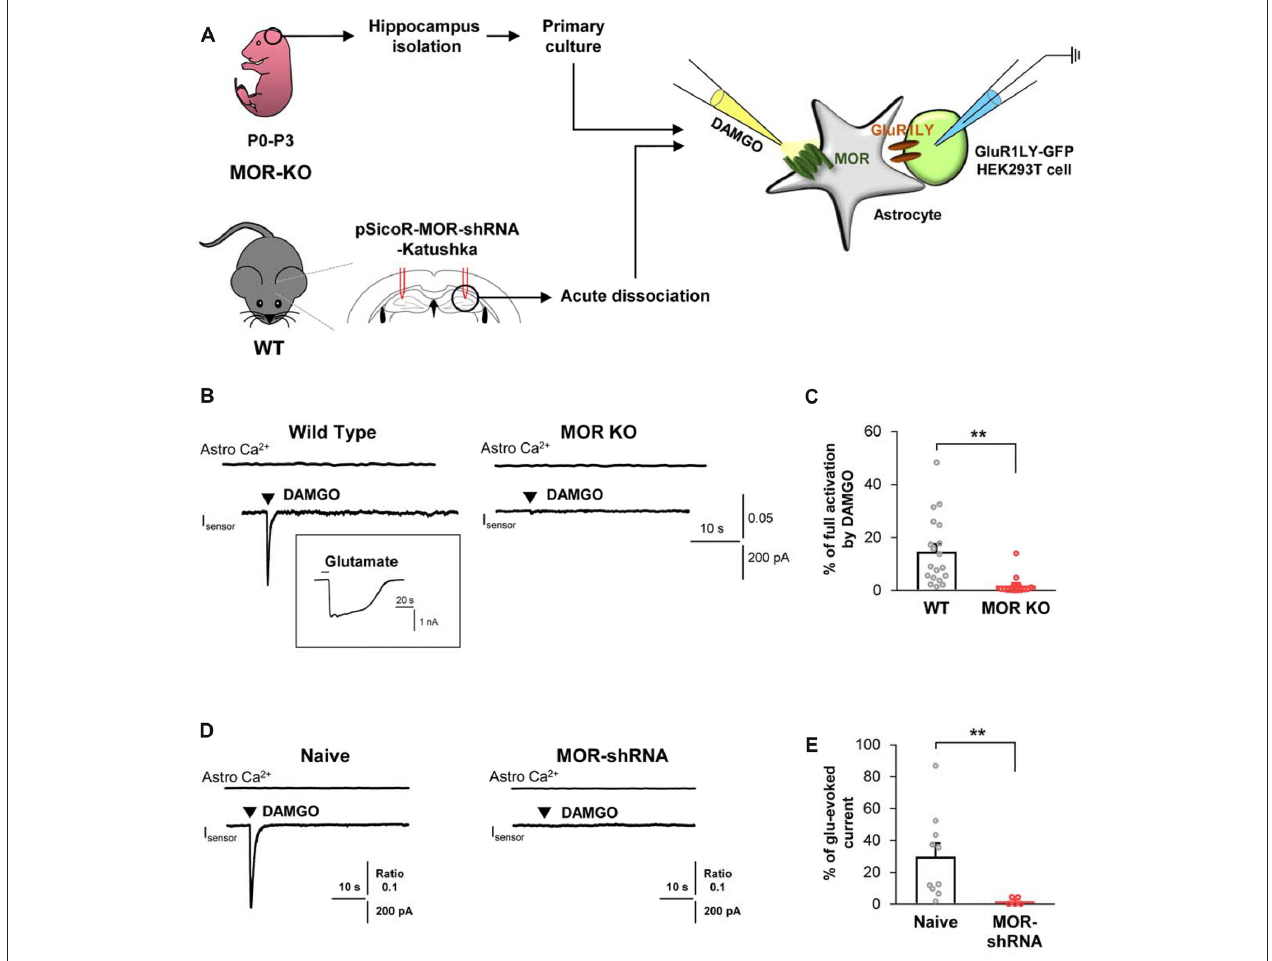
FIGURE 2 | DAMGO-induced astrocytic glutamate release is caused by MOR activation. (A) Schematic diagram for sniffer-patch with primary cultured hippocampal astrocytes prepared from MOR knockout (KO) mouse or acutely dissociated astrocytes from pSicoR-MOR-shRNA-Katushka-injected hippocampus of wild-type (WT) mouse. (B) Representative traces of Ca 2 + response and inward current induced by DAMGO in primary cultured hippocampal astrocyte of WT and MOR KO mice. Inset indicates an example trace of full activation current induced by bath application of 1 mM glutamate. (C) Summary bar graph for DAMGO-induced glutamate current normalized by the full activation current in WT and MOR KO mice. Numbers in the bar graph indicate the number of cells tested from at least three independent mice for each group. Unpaired t -test ( ∗∗ P < 0.01). (D) Representative traces of Ca 2 + response and inward current naïve or MOR-shRNA-infected astrocyte. (E) Summary bar graph for DAMGO-induced glutamate current normalized by the full activation current in naive and MOR-shRNA-infected astrocytes. Numbers of tested cells are indicated on each bar. Unpaired t -test with Welch’s correction ( ∗∗ P <